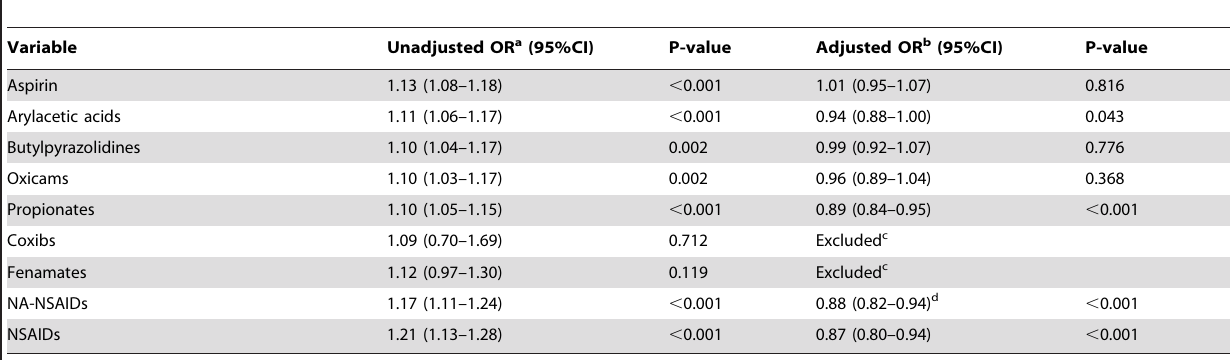
Table 3. Effect of ever filling a prescription of an NSAID class on the risk of developing prostate cancer.